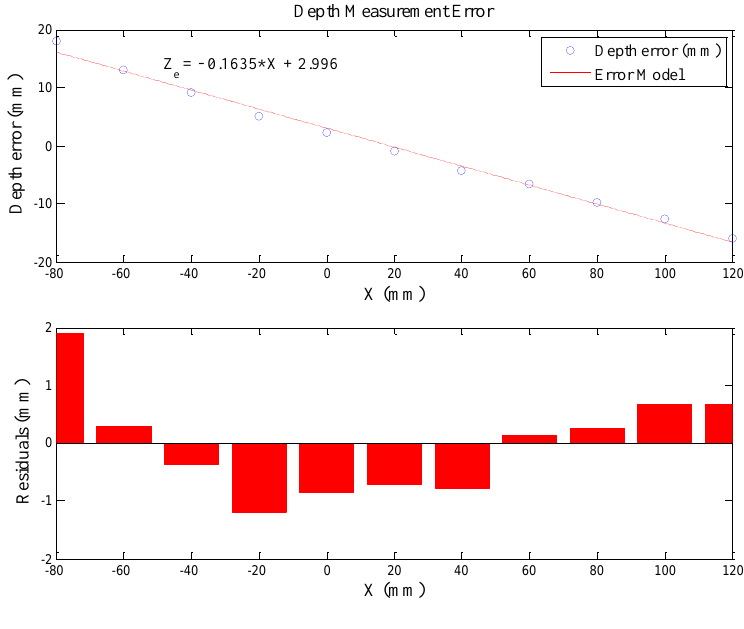
Figure 14. Linear depth measurement error